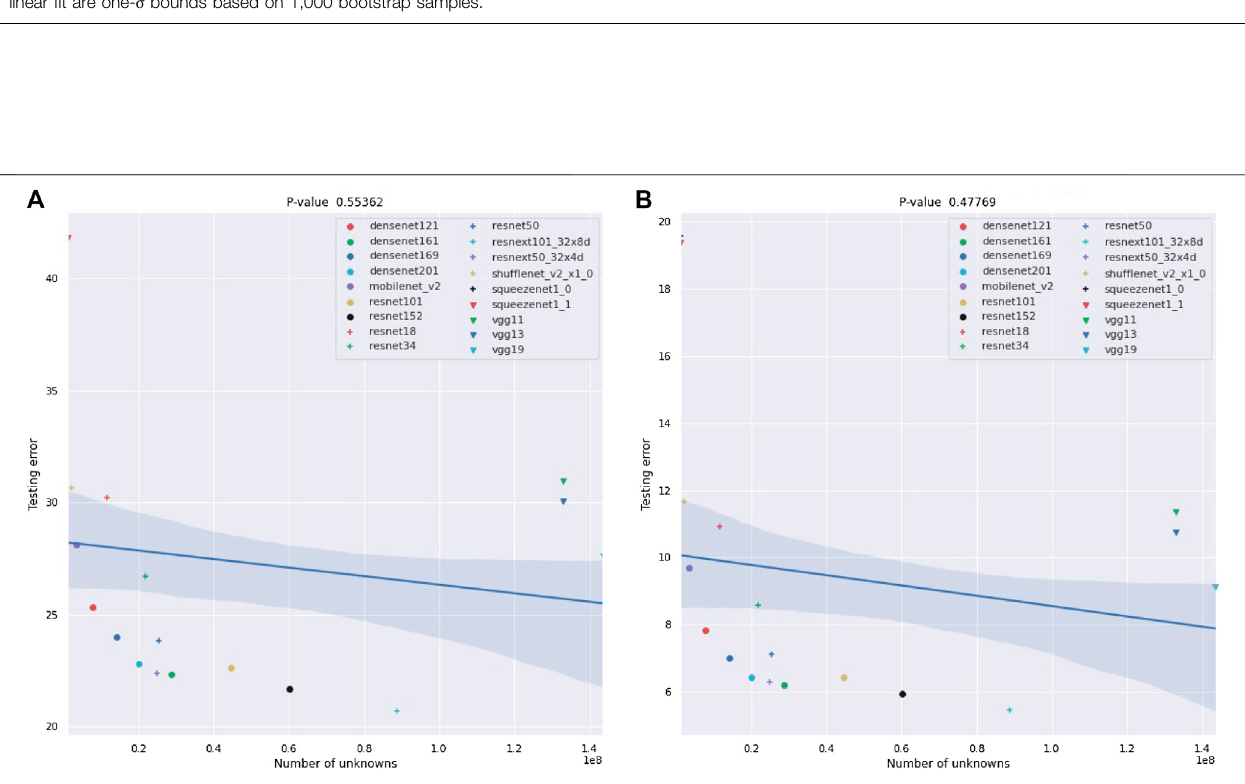
FIGURE 13 | Plots of the best-1 and best-5 testing errors of NNs against the number of parameters. Again, the testing errors are as provided by [30] and are error rates for testing on ImageNet crop images. The number of parameters in the network is not a statistically signi fi cant predictor of their performance. The con fi dence bounds on the linear fi t are one- σ bounds based on 1,000 bootstrap